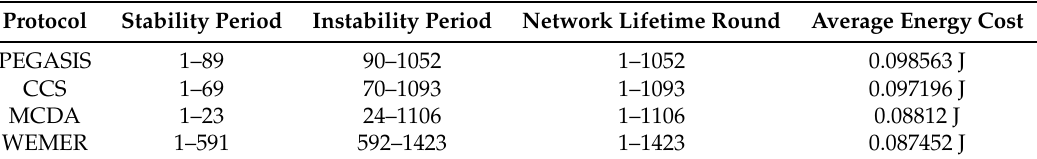
Table 4. Comparison of the proposed WEMER with contemporary protocols in terms of longevity and energy consumption when area is 250 250 m 2 and N = 200. ×